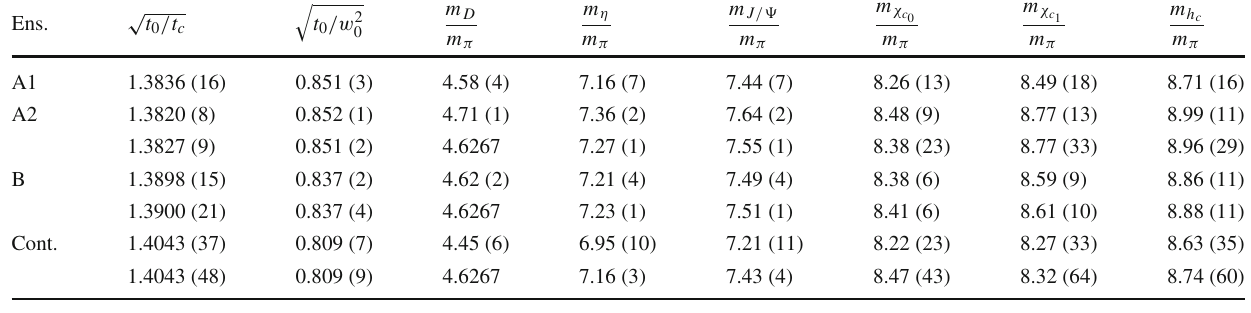
Fig. 3 Comparison of continuum limit extrapolations √ t 0 / t c (bottom) and of (top) of our N f = 3 + 1 data (right) with corresponding N f = 3 CLS results (left) from [9,38] including the finest ensemble J500, cf.